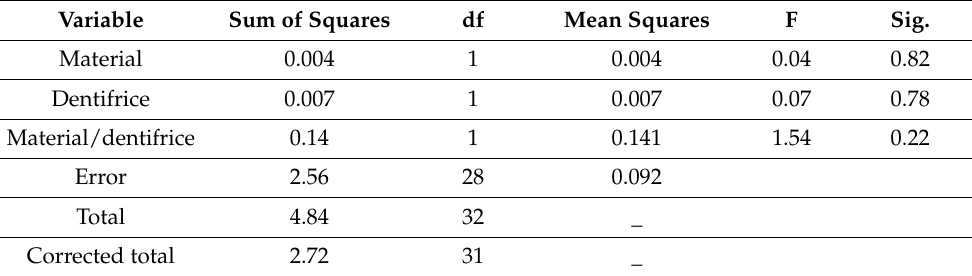
Table 13. Influence of material and dentifrice on surface roughness using two-way ANOVA. Variable Sum of Squares df Mean Squares F Sig. Material 0.004 1 0.004 0.04 0.82 Dentifrice 0.007 1 0.007 0.07 0.78 Material/dentifrice 0.14 1 0.141 1.54 0.22 Error 2.56 28 Corrected